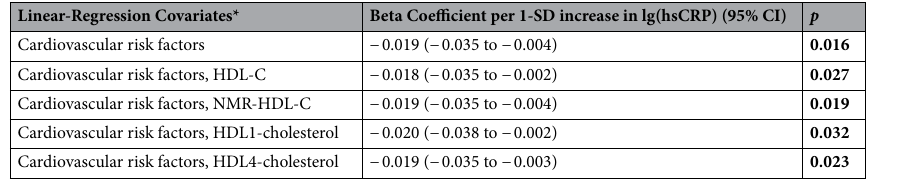
Table 3. Multiple linear regression analysis between hsCRP and cholesterol efflux capacity in CAD patients (n = 36). Cardiovascular risk factors included: age, male sex, LDL-C, diabetes, current smoking, body mass index, triglycerides (log-transformed). hsTnT (log-transformed); hsCRP, high-sensitivity C-reactive protein; CAD, coronary artery disease; NMR-HDL-C, NMR-determined high-density lipoprotein cholesterol. Boldface type emphasizes significant